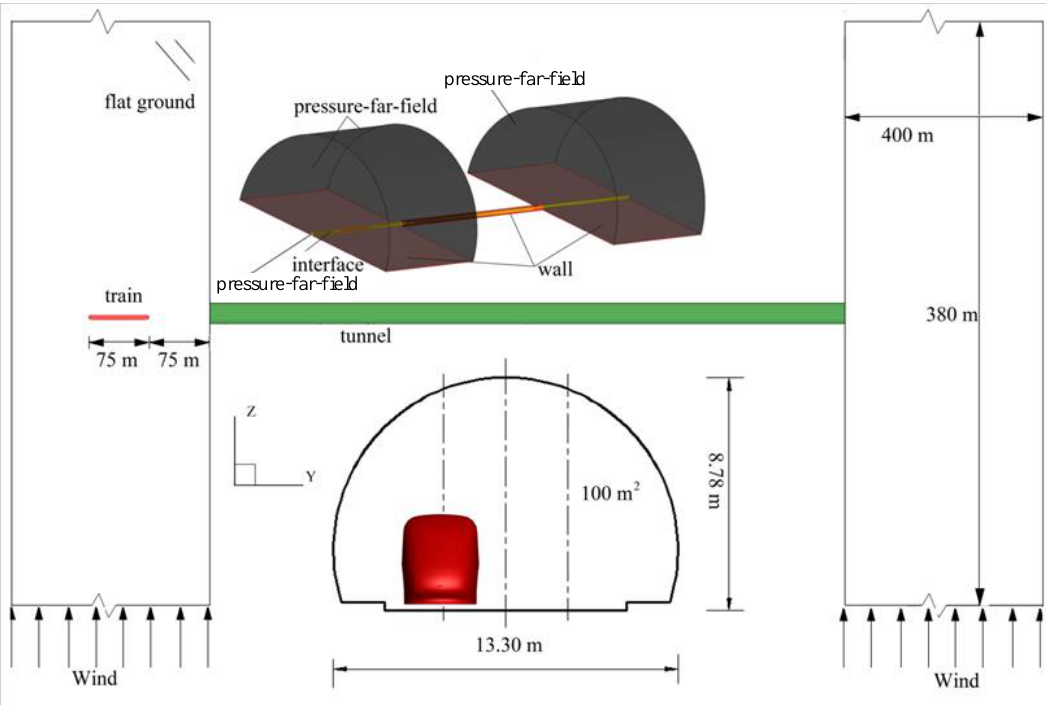
Figure 6. Typical numerical configuration of plan view.